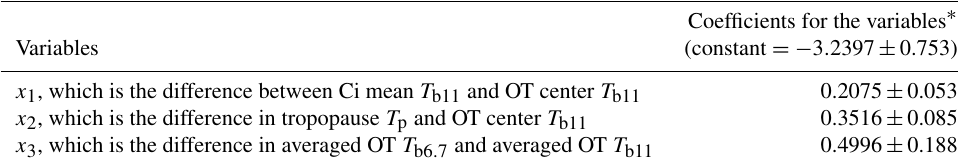
Table 1. A summary of the regressed coefficients for the variables selected for OT detection used in Eq. (1). Variables (constant = − 3 . 2397 ± 0.753) x 1 , which is the difference between Ci mean T b11 and OT center T b11 0.2075 ± 0.053